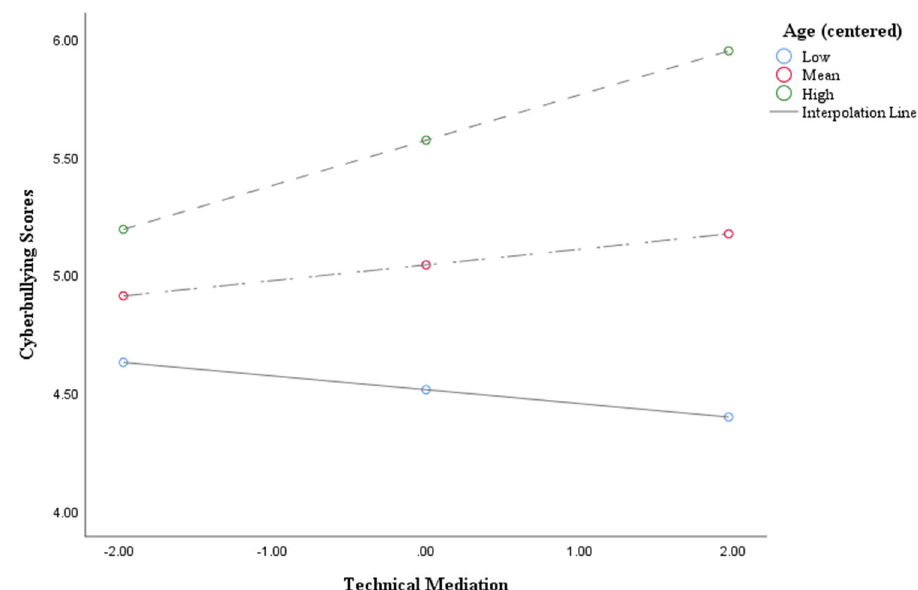
Fig. 1 Three-way interaction between technical mediation, age, and gender for